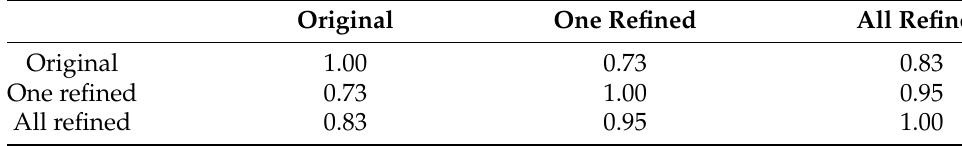
Table 1. Correlation coefficients (cohort